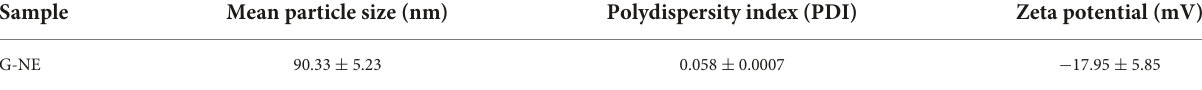
TABLE 1 Basic characteristics of